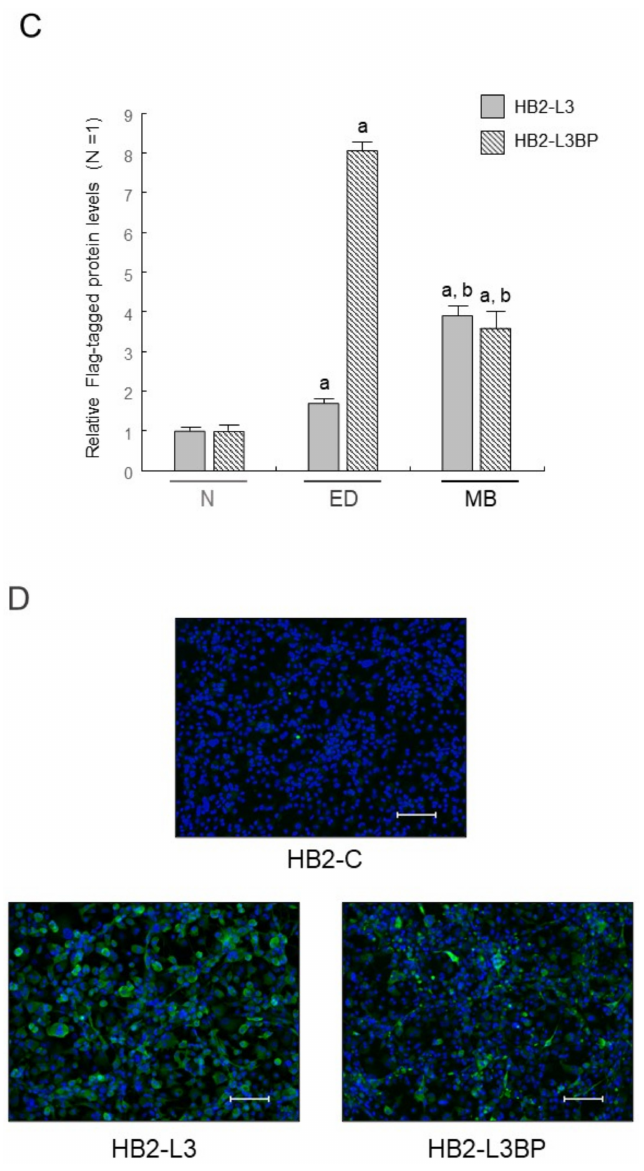
Figure 1. Establishing HB2 cells that overexpress Lgals3 and Lgals3bp. ( A ) Expression levels of Lgals3 and Lgals3bp mRNA in HB2 transfectants. Total RNAs were extracted from each mature HB2 transfectant and then subjected to real time quantitative PCR. The expression levels of Lgals3 or Lgals3bp mRNA were normalized using the 18S rRNA level as the standard. The values shown in the bar graphs are related to an arbitrary unit of the HB2-C cells (set to 1), and the means ± SE values ( n = 3) are given: a p < 0.05 vs. HB2-C cells; b p < 0.05 vs. HB2-L3bp cells; c p < 0.05 vs. HB2-L3-L3bp cells; and d p < 0.05 vs. HB2-L3 cells. ( B ) Expression levels of Flag-Lgals3 and Flag-Lgals3bp proteins in the cell lysate and the culture medium of HB2 transfectants. Cellular protein extracts and cell culture media of each HB2 transfectant at different differentiation stages (N: not differentiated; ED: early phases of brown adipocyte differentiation; MB: mature brown adipocyte) were collected and then subjected to Western blot analysis. Flag-tag proteins were detected by anti-DYKDDDDK (Flag) antibody. β -tubulin probe was used as a loading control. ( C ) Relative expression levels of Flag-Lgals3 or -Lgals3bp protein in culture medium of HB2-L3 or -L3bp cells. The values shown in the bar graphs are related to an arbitrary unit of the N stage (set to 1), and the means ± SE values ( n = 3) are given: a p < 0.05 vs. N stage; b p < 0.05 vs. ED stage. ( D ) Flag-tag protein in mature HB2-C, HB2-L3, or HB2-L3bp cells was stained using an anti-Flag antibody. Representative photomicrographs of each cell are shown. Each scale bar indicates 50 µ